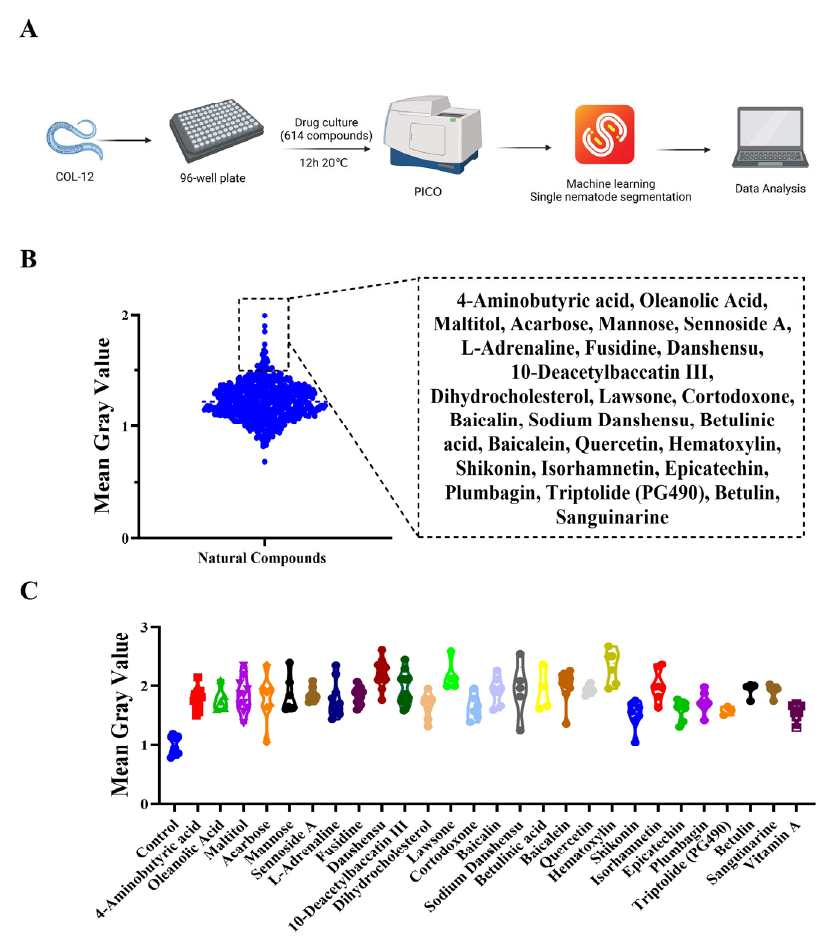
Figure 4. Compound library screening for promoting COL-12 expression ( A ) Drug screening flow chart; ( B ) Results of preliminary drug screening, where 614 compounds from the compound library were tested on the COL-12 model at a single concentration of 100 µ M, n = 30; ( C ) Single nematode data for effective compound groups, n ≈ 7.